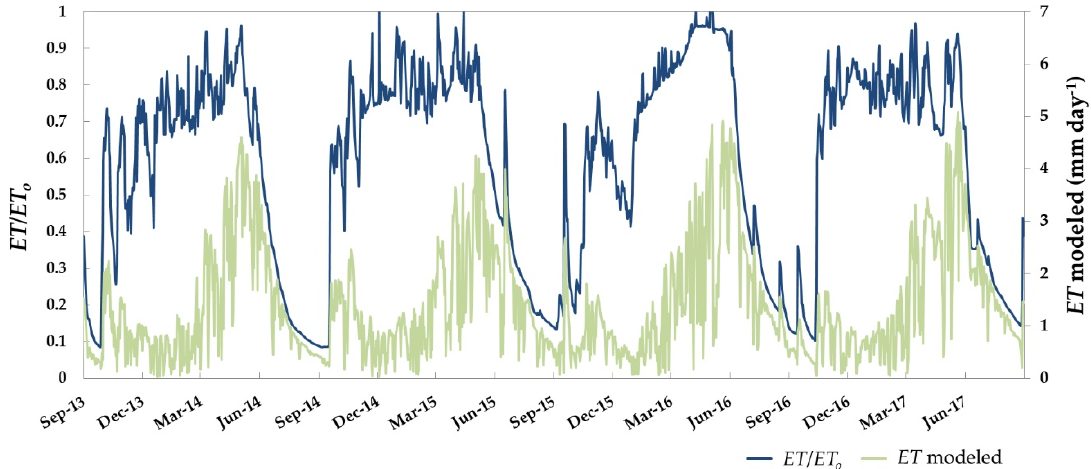
Figure 7. Daily evapotranspiration ( ET ) monitoring and water stress (ratio between evapotranspiration and reference evapotranspiration, ET / ET o ) over the dehesa ecosystem.